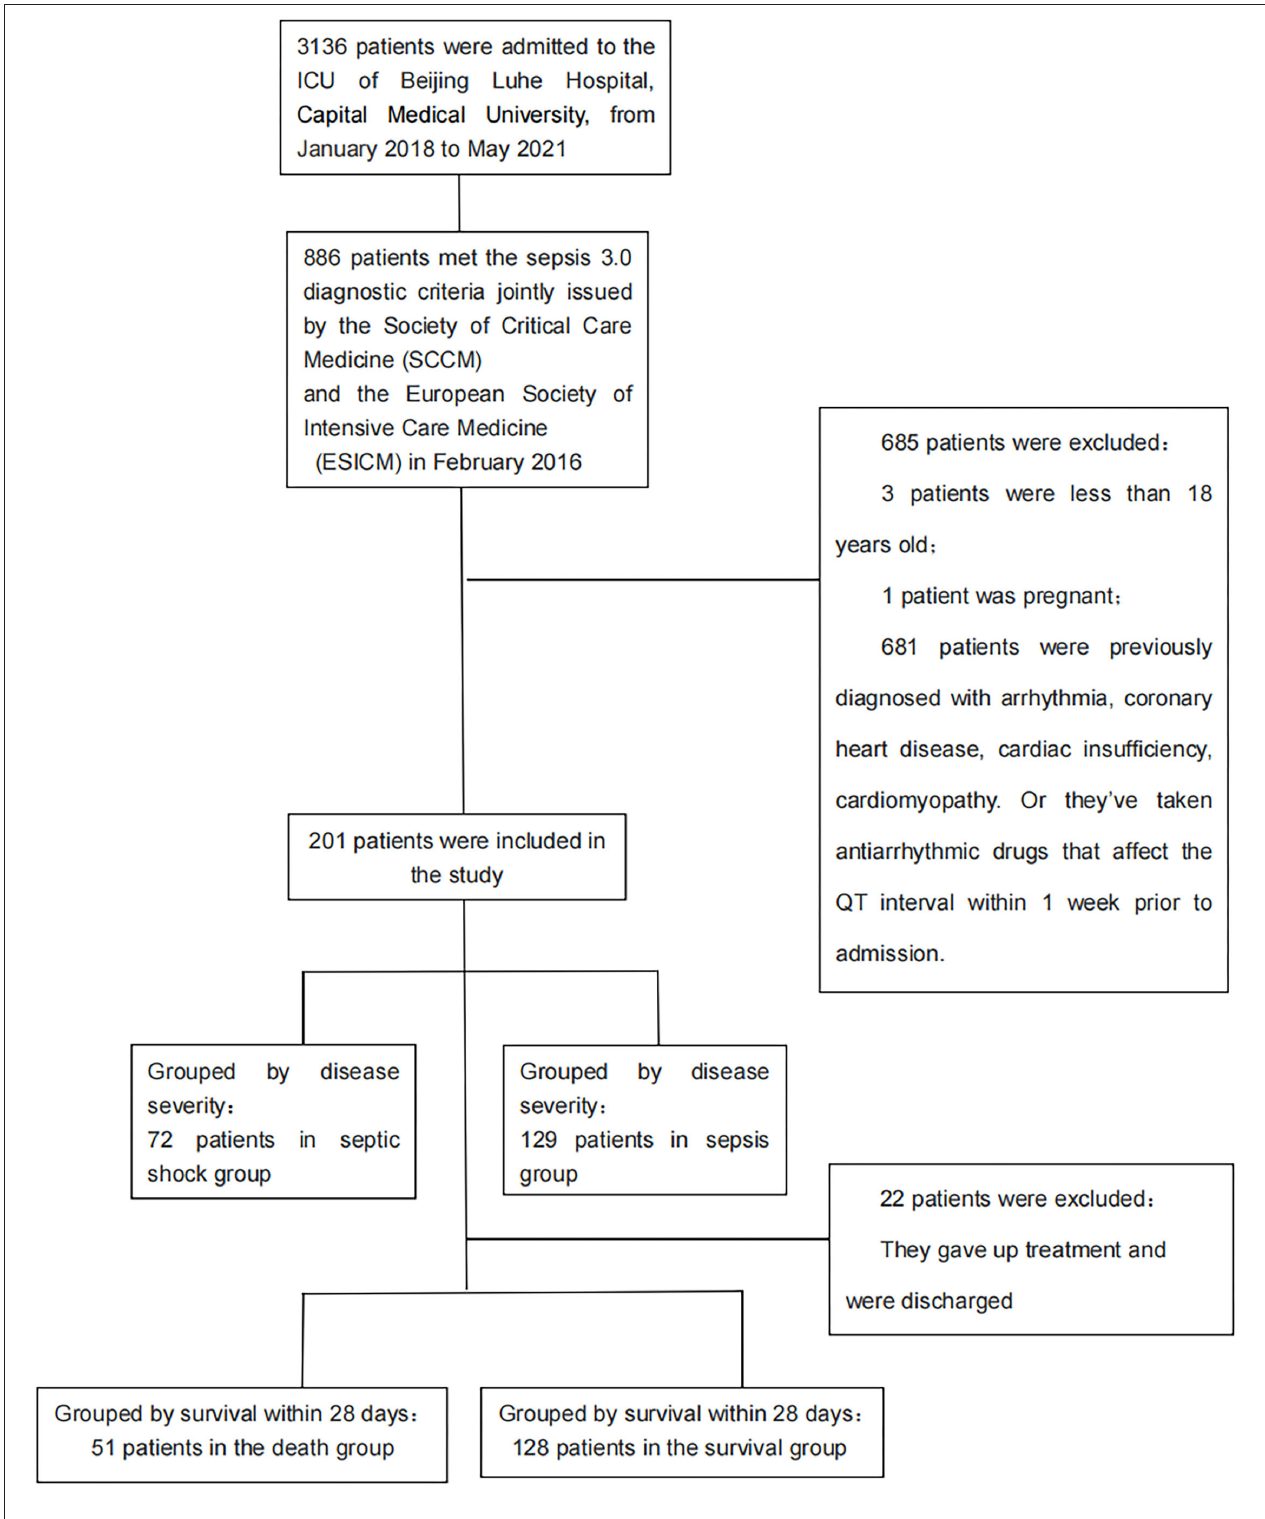
FIGURE 1 | Flow diagram of sepsis patients selection.